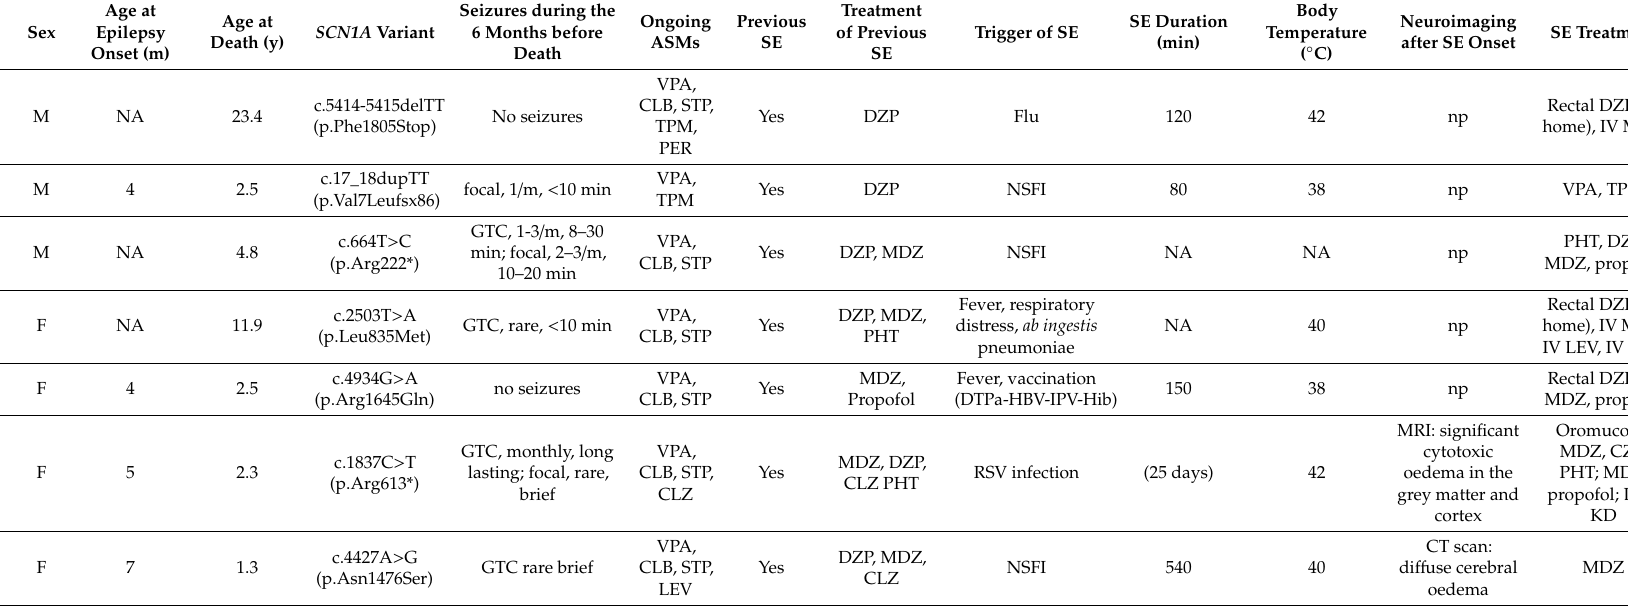
Table 1. Clinical features, epilepsy history, and fatal status